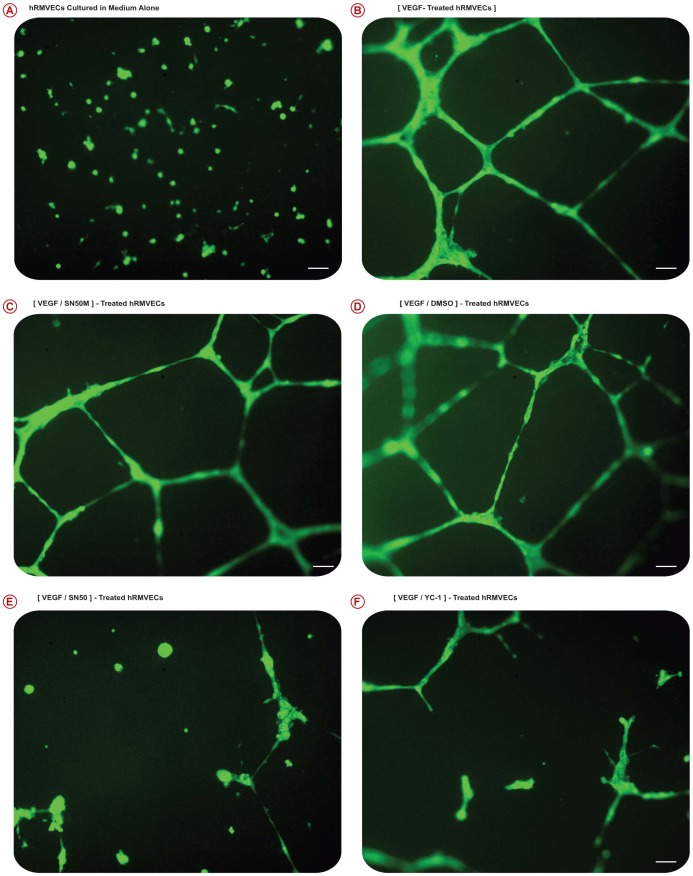
YC-1 Displays Anti-Angiogenic Properties via the Inhibition of VEGF-Stimulated Tube Formation of hRMVECs.Representative micrographs exhibit the presence of cobblestone-like appearance when cells are grown in the absence of VEGF [A]. In the control groups [B, C, and D]; exposure of hRMVECs to VEGF165 [30 ng/ml] within 24 hours caused a rapid alignement of cells with one another to form tube-like structures. VEGF stimulation caused an increase in the elongation of the tube-like structures and the numbers of their tube multicentric junctions. Treatment with SN50 [E] or YC-1 [F] or caused a severe abrogation to the tube formation. Scale bars 75 mm.